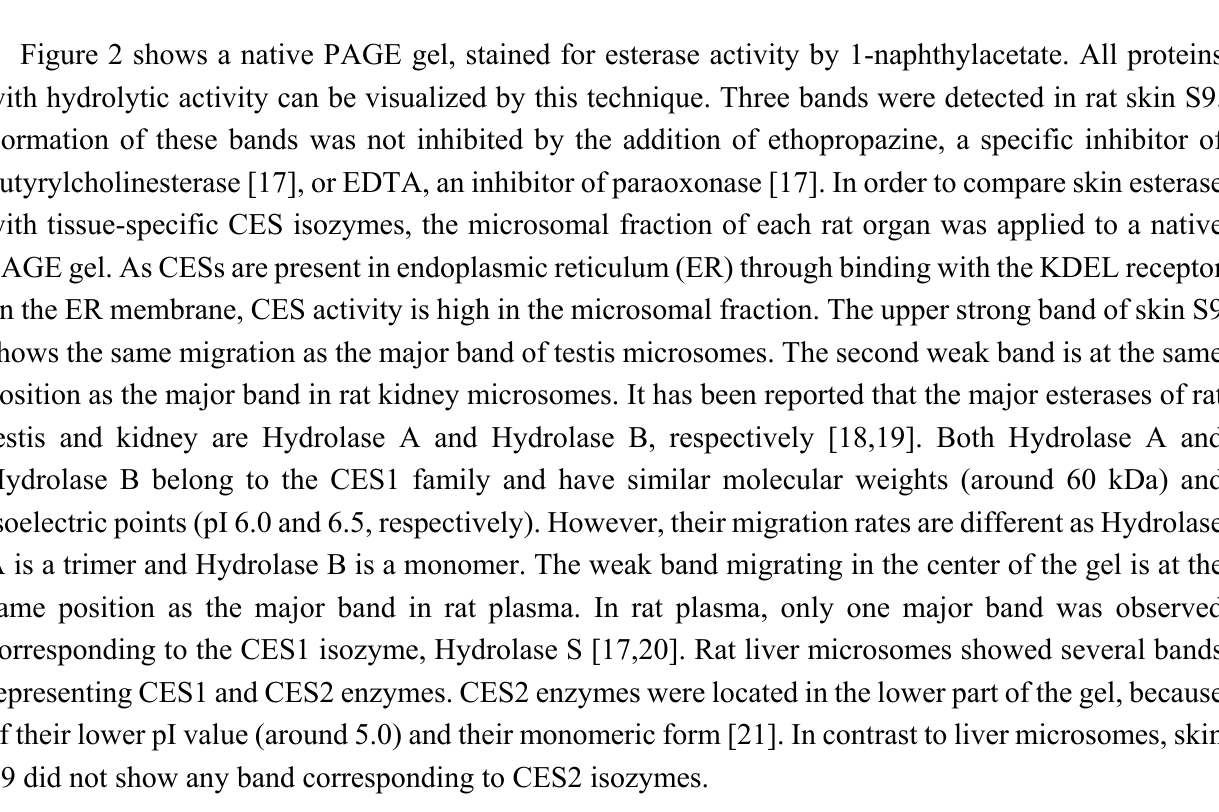
Figure 2. Electrophoretic pattern of esterase in several rat tissues. 1-Naphthol, a dye derived from hydrolysis of 1-naphthylacetate, was used to detect esterases in polyacrylamide gel electrophoresis (PAGE) through the formation of an insoluble complex with Fast Red TR. The quantities of skin S9 and tissue microsomal proteins loaded were 40 and 10 μ g, respectively. Arrows indicate the bands corresponding to each carboxylesterase 1 (CES1)